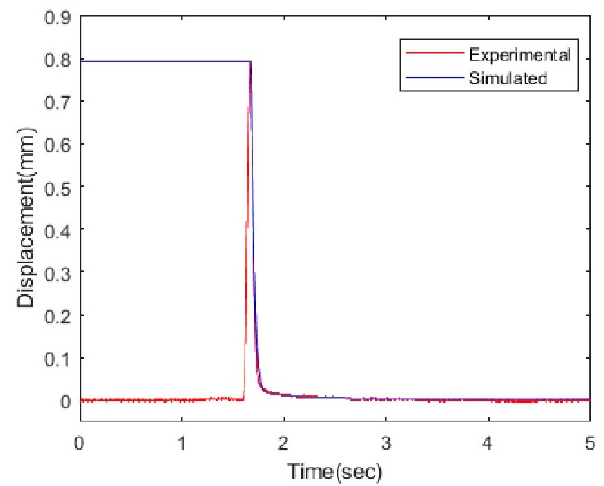
Figure 26. Step response of non-conductive material without VCA.